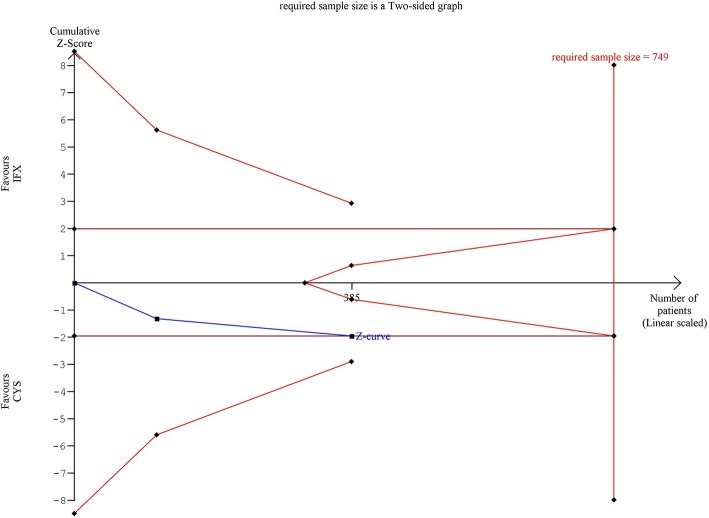
Results of the trial sequential analysis of the risks of adverse events. The required sample size was calculated with α = 0.05 (two-sided) and ß = 0.02 (power of 80%). Although cumulative Z-curve (blue) reached the conventional boundary, it did not cross through. Number of participants (385) did not reach the information size (749) and the cumulative Z-curve does not cross the monitoring boundary either.